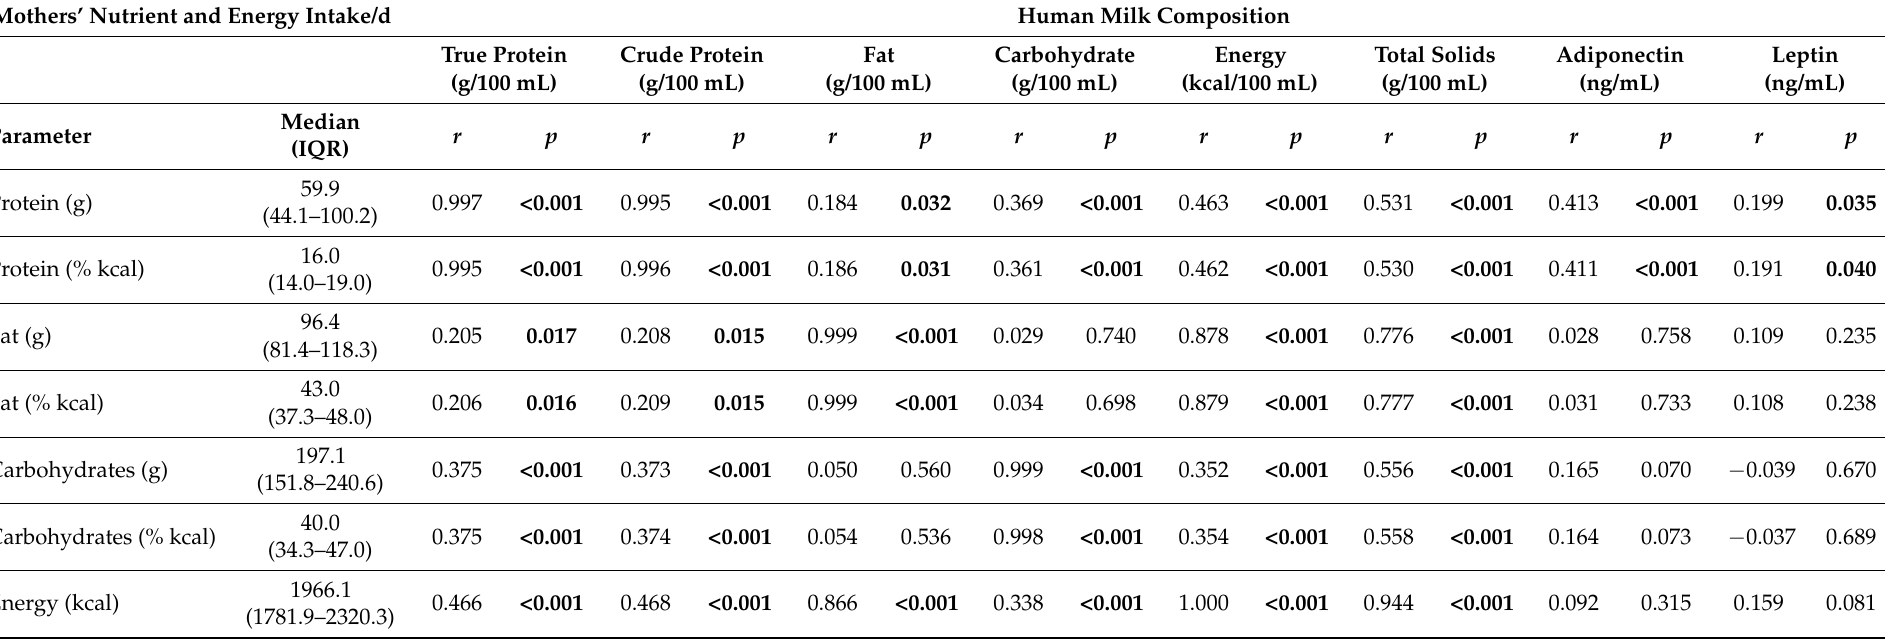
Table 3. Correlation between maternal nutrition and human milk